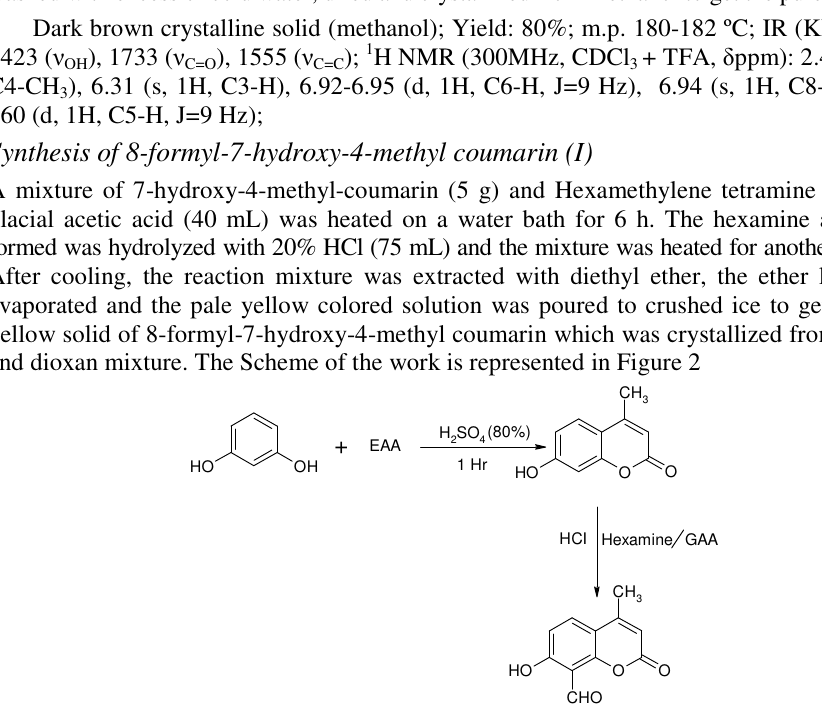
Figure 2. Systematic scheme for preparation of coumarin